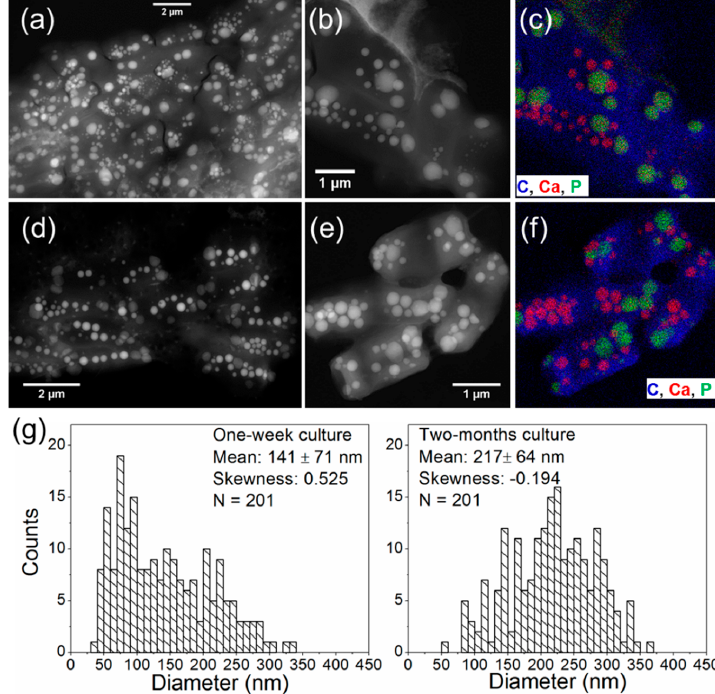
Figure 8. HAADF-STEM images and STEM-EDXS maps of Ca . G. lithophora C7 cells grown in BG-11 for one week ( a – c ) or two months ( d – f ). ( a , d ) show low-magnification HAADF-STEM images of tens of cells; ( b , e ) show high-magnification HAADF-STEM images of several cells which were analyzed by EDXS mapping; ( c , f ) show overlaid elemental maps where each color corresponds to one element indicated by its own symbol with the same color; ( g ) Particle size distributions of carbonate inclusions grown for one week ( left panel ) and two months ( right panel ).